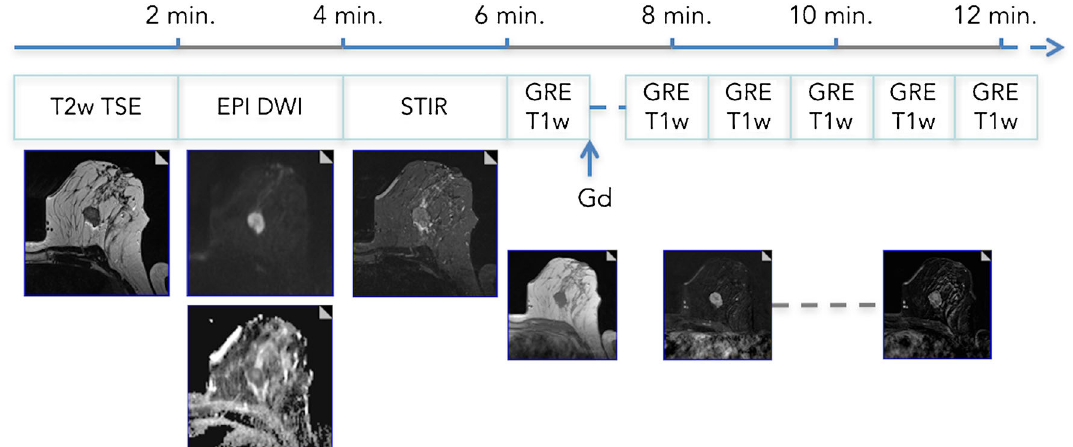
Fig. 1 Multiparametric bMRI protocol. A full triparametric bMRI protocol can be acquired in 15 min of magnet time. Patient preparation, including venous catheter placement, should be done outside the scanner room. The (recommended) axial protocol starts with precontrast T2w- TSE, DWI, and STIR (optional) sequences. Here, a mass lesion in a